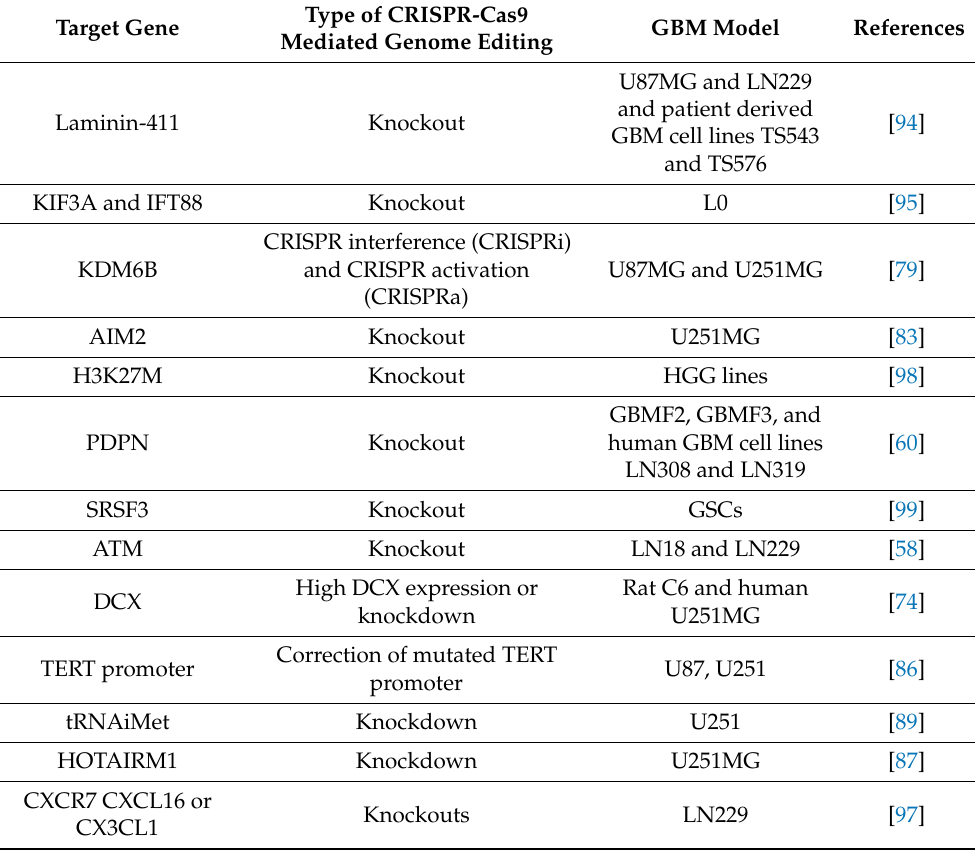
Table 7. CRISPR-Cas9 mediated knockouts of the proliferation-related genes in GBM. Type of Target Gene